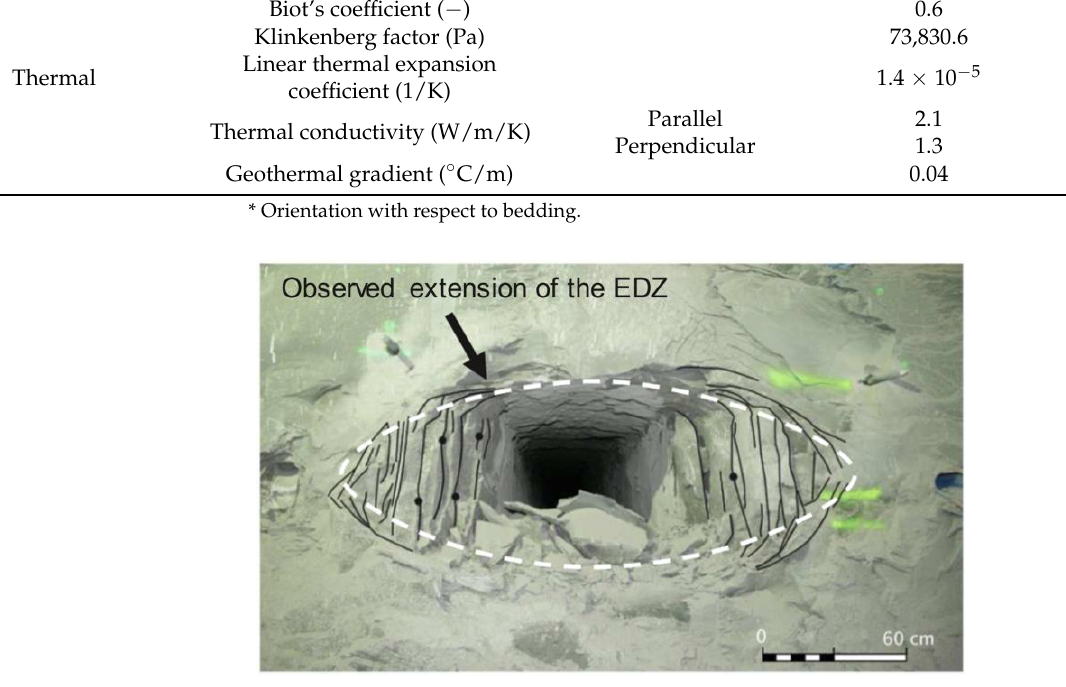
Figure 8. The observed fractures around the micro-tunnel in COx claystone induced by excavation. Reprinted from [5] with permission from Elsevier.